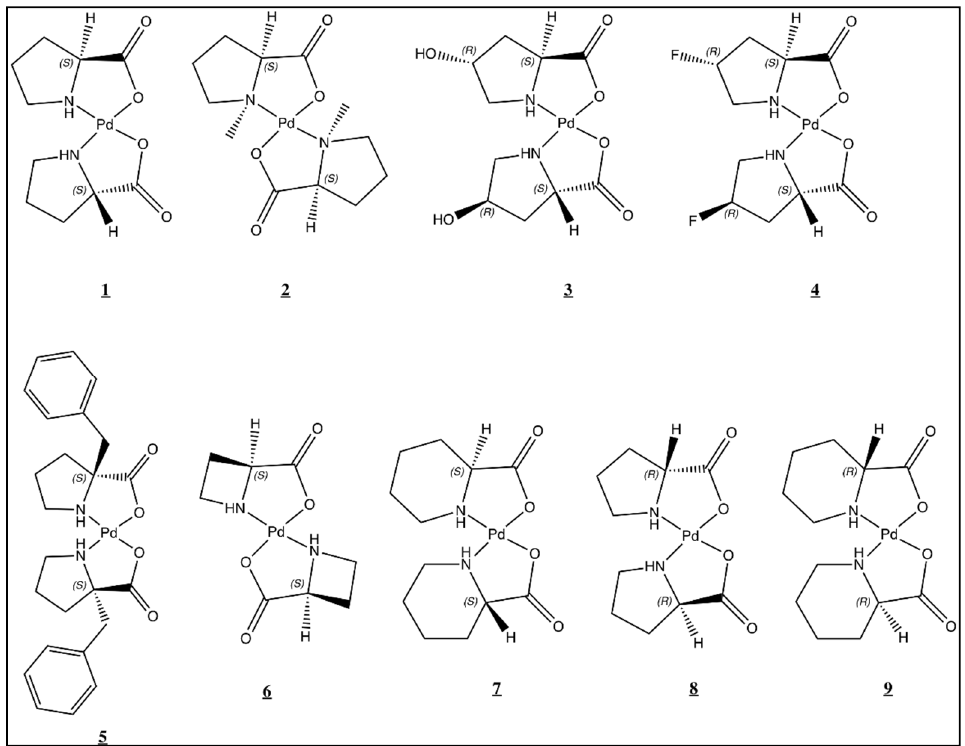
Figure 1. Compound structures and numbering scheme for proline and proline homolog complexes. Stereochemistry is shown at all chiral centers.